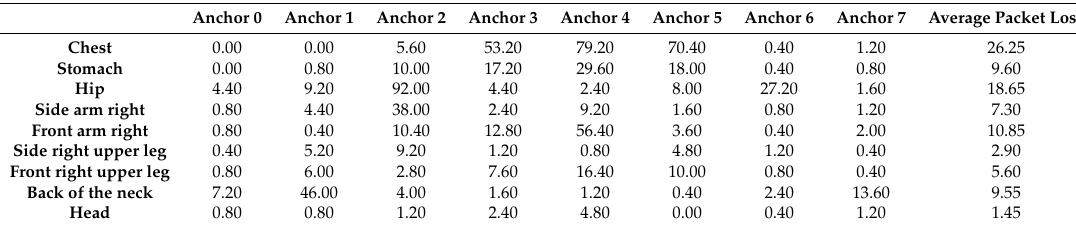
Table 2. Packet loss (%) per anchor depending on tag placement.